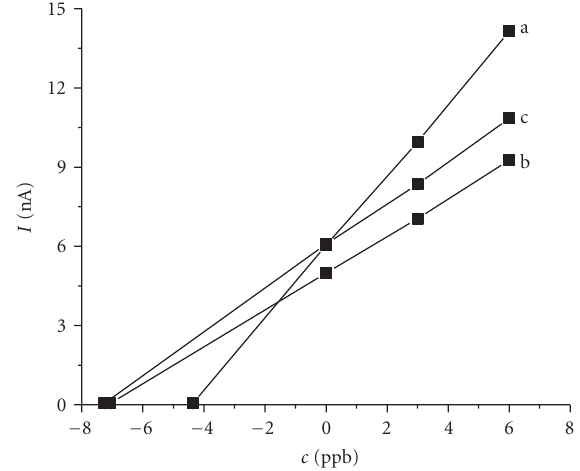
Figure 4: Standard addition calibration curve for lead in (a) Original Sample , (b) SoUV Sample, and (c) UV Sample.